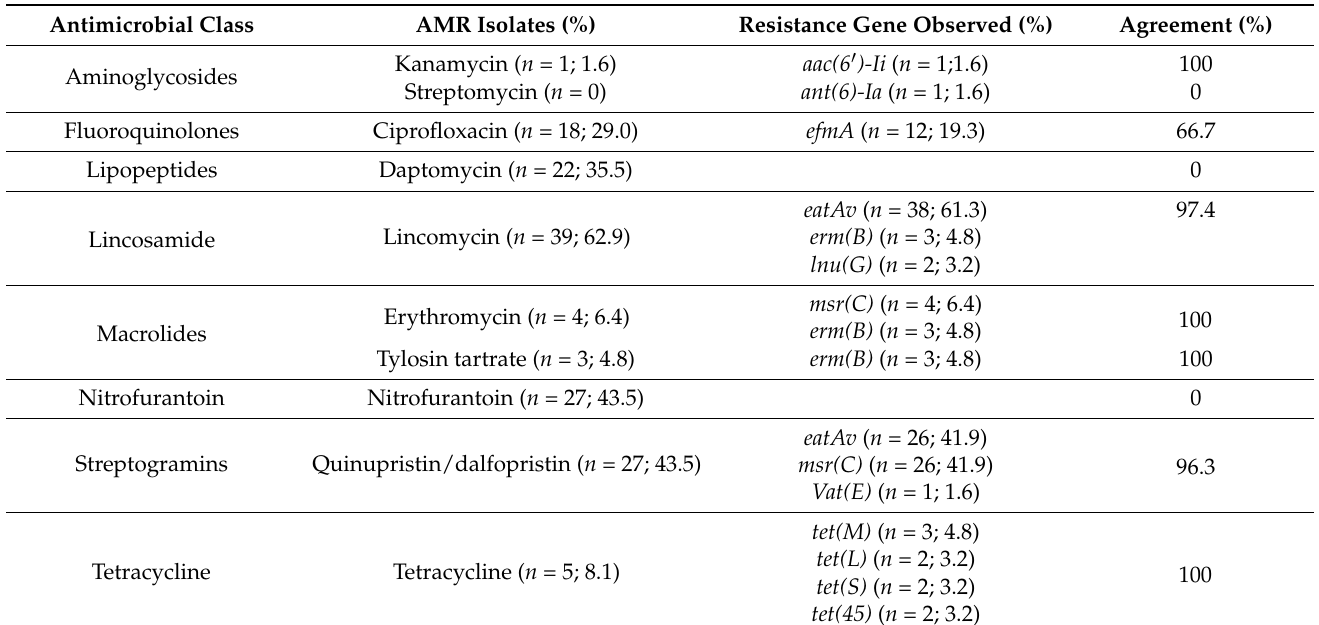
Table 6. Agreement between phenotypic and genotypic resistance among the 62 E. faecium isolates subjected to whole genome